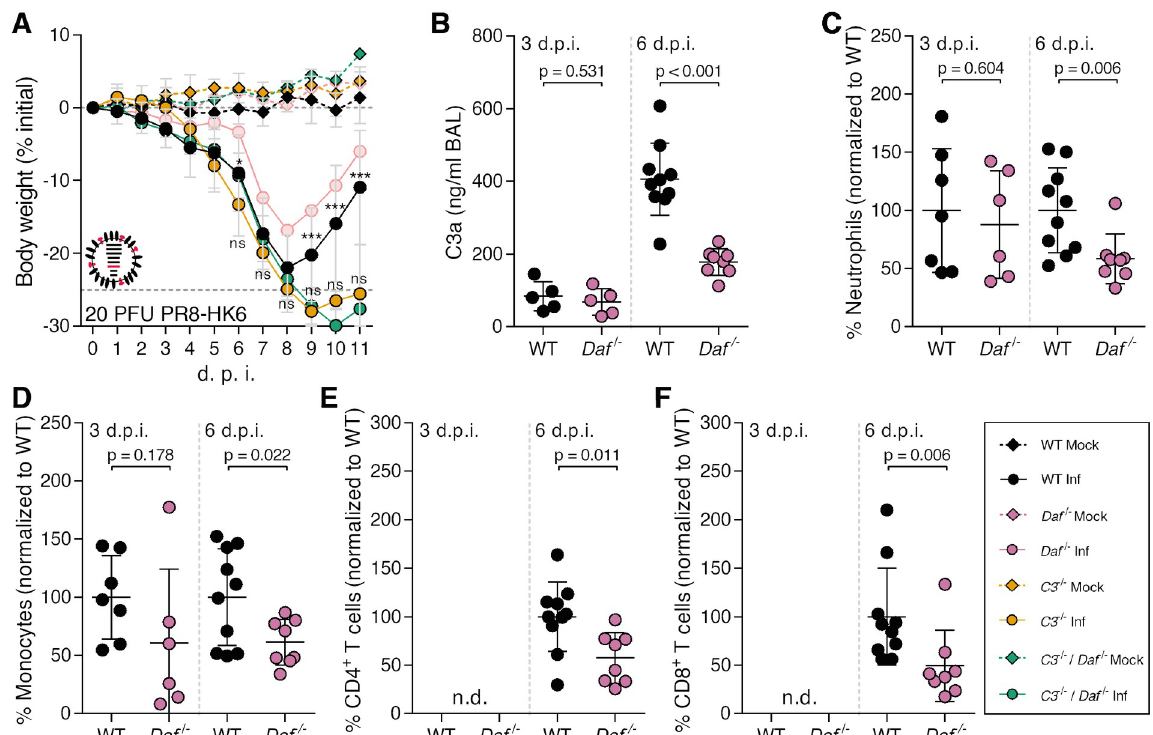
Fig 7. Daf -/- mice have reduced complement activation and T cell recruitment upon PR8-HK6 infection. A : Bodyweight loss of C57BL/6J WT, Daf -/- , C3 -/- or C3 -/- / Daf -/- mice infected with 20 PFU of A/Puerto Rico/8/1934 with segment 6 from A/Hong Kong/1/68 (PR8-HK6) (Inf n = 26, n = 18, n = 10 and n = 4, mock n = 10, n = 7 n = 3 and n = 1, for WT, C3 -/- , C3 -/- / Daf -/- and Daf -/- respectively). Results are expressed as mean ± sd. B : C3a levels in BALs of C57BL/6J WT or Daf -/- mice at 3 d.p.i. (n = 5 per group) and 6 d.p.i. (WT n = 10 and Daf -/- n = 8) with 20 PFU of PR8-HK6. Results are expressed as mean ± sd. C, D, E, F : Analysis of neutrophils ( C ), monocytes ( D ), CD4 + T cells ( E ) and CD8 + T cells ( F ) levels in BALs of WT and Daf -/- mice at 3 and 6 d.p.i. (n = 7 and n = 6 for WT and Daf -/- mice respectively) with 20 PFU PR8-HK6. Samples with non detectable cell levels are noted as n.d.. Results are expressed as mean ± sd from two independent experiments. A